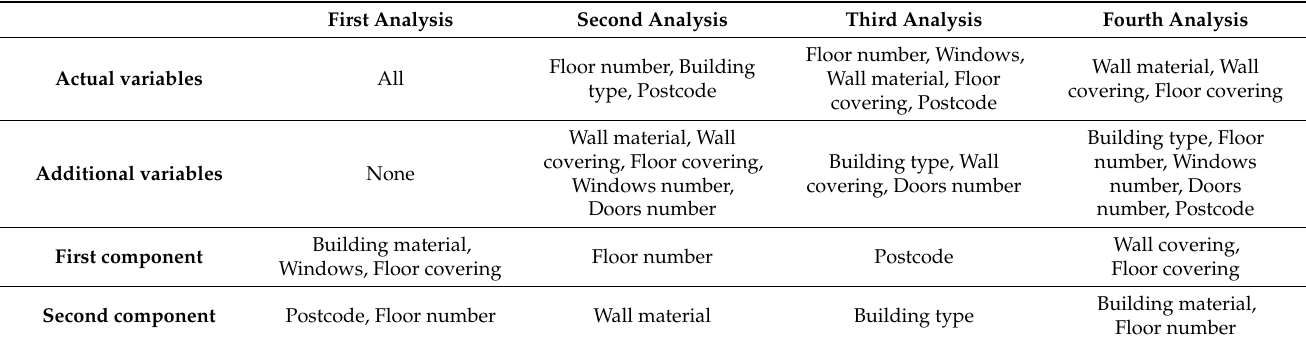
Table 1. Parameters of the four PCA analyses carried out on indoor radon